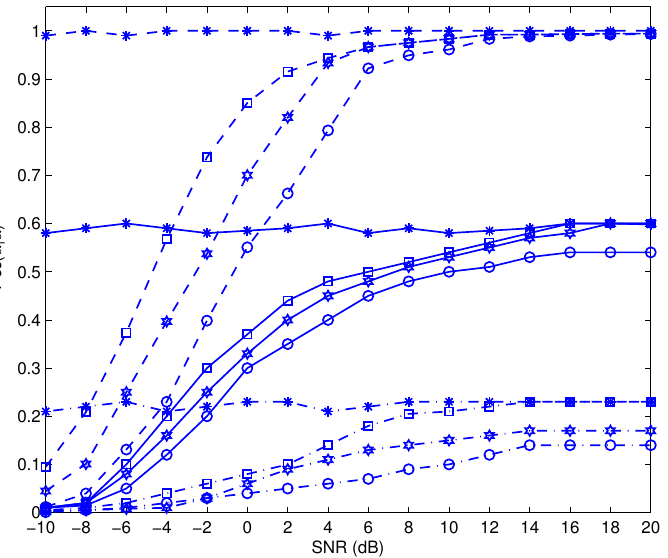
Figure 14. Awareness performance comparison with the modulation set θ 4 . Dashed lines represent the proposed method, sold lines are used for the method of [10], and dot-dashed are used for the method of [25]. Star, square, hexagram, and circle markers refer to 8 − PSK, BPSK, 64 − QAM, and QPSK modulations,